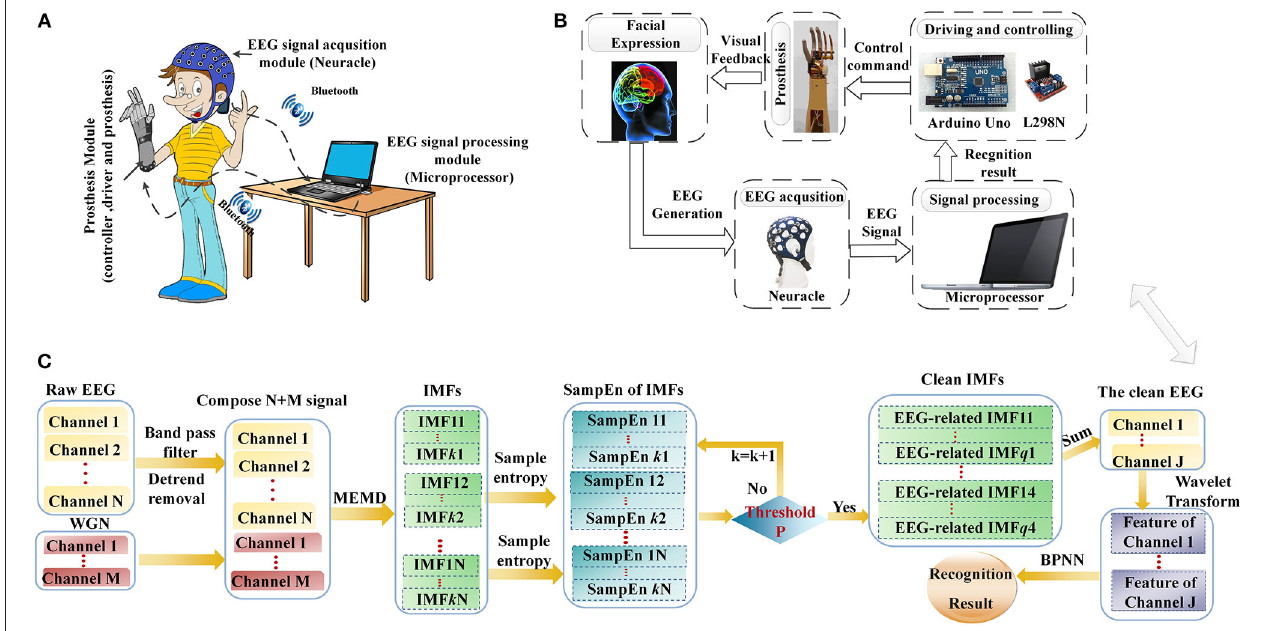
FIGURE 1 | The brain-controlled prosthesis system based on facial expressions and its schematic description. (A) The 2-DOFs brain-controlled prosthesis system. (B) A schematic of the FE-BCI system-controlled prosthesis. (C) Flowchart of EEG signal processing.